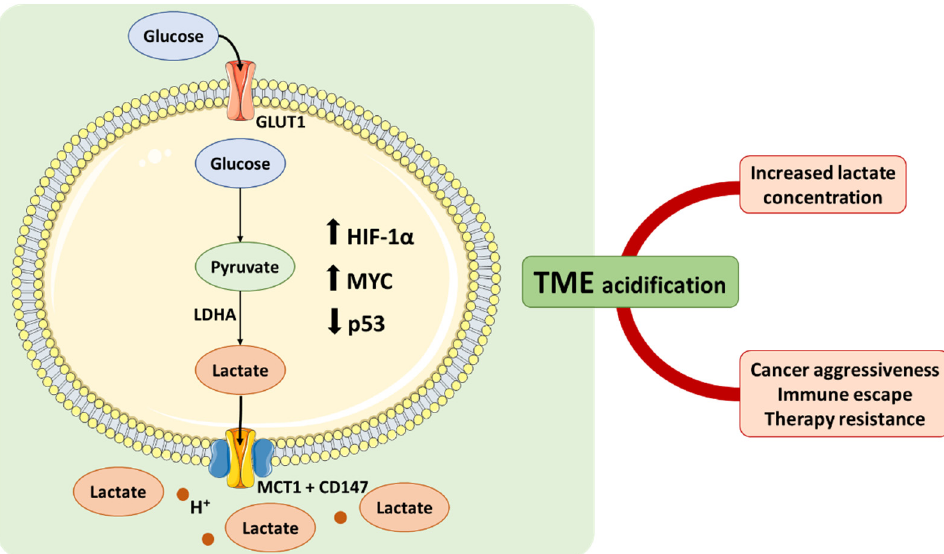
Figure 1. The Warburg effect and its implications on the tumor microenvironment. HIF-1 α activation during hypoxic stress, oncogenic activation (e.g., c-myc ), or loss of tumor suppressors (e.g., p53) leads to increased glucose consumption, acceleration of its metabolism, and increased lactate production. The consequent acidification of the TME promotes cancer aggressiveness, immune escape, and therapy resistance (GLUT1, glucose transporter 1; HIF-1 α , hypoxia-inducible factor 1 α ; LDHA, lactate dehydrogenase A; MCT1, monocarboxylate transporter 1; TME, tumor microenvironment).